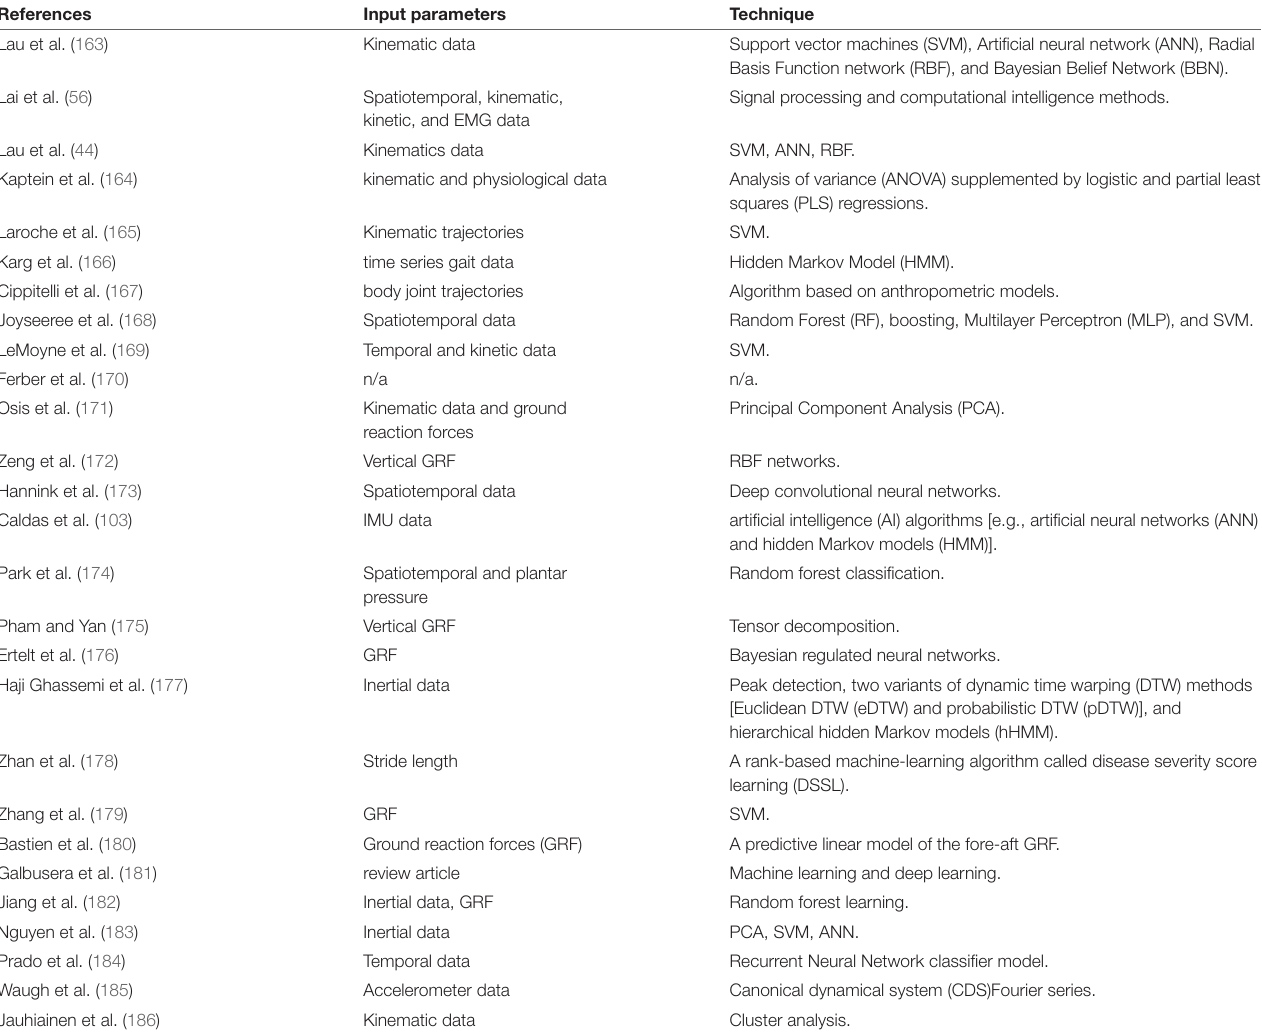
TABLE 6 | An overview of the AI techniques applicable for gait analysis.